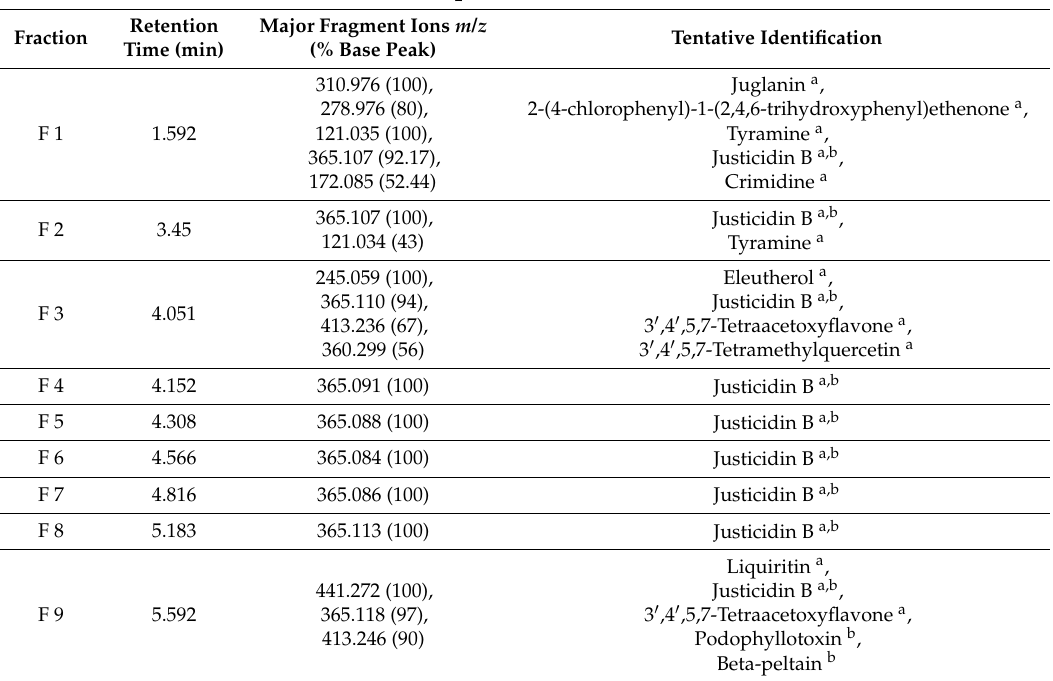
Table 3. Summary data of the nine collected fractions (F1–F9), their retention time and tentative identified